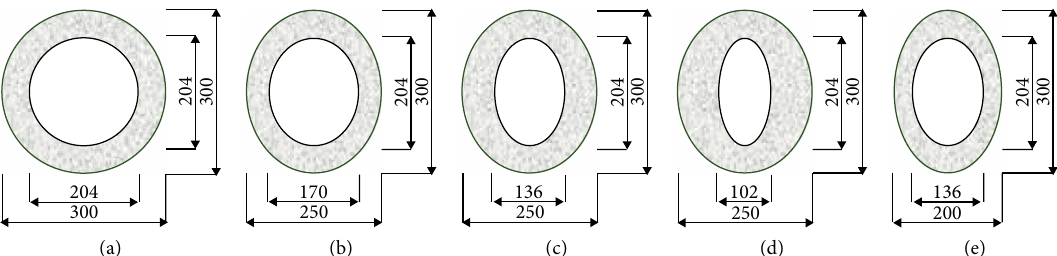
Figure 2: Elliptical DSTCs with an elliptical steel tube. (a) EC1-ec1-F6. (b) EC2-ec2-F3 and EC2-ec2-F6. (c) EC2-ec3-F6. (d) EC2-ec4-F6. (e) EC3-ec3-F3 and EC3-ec3-F6.